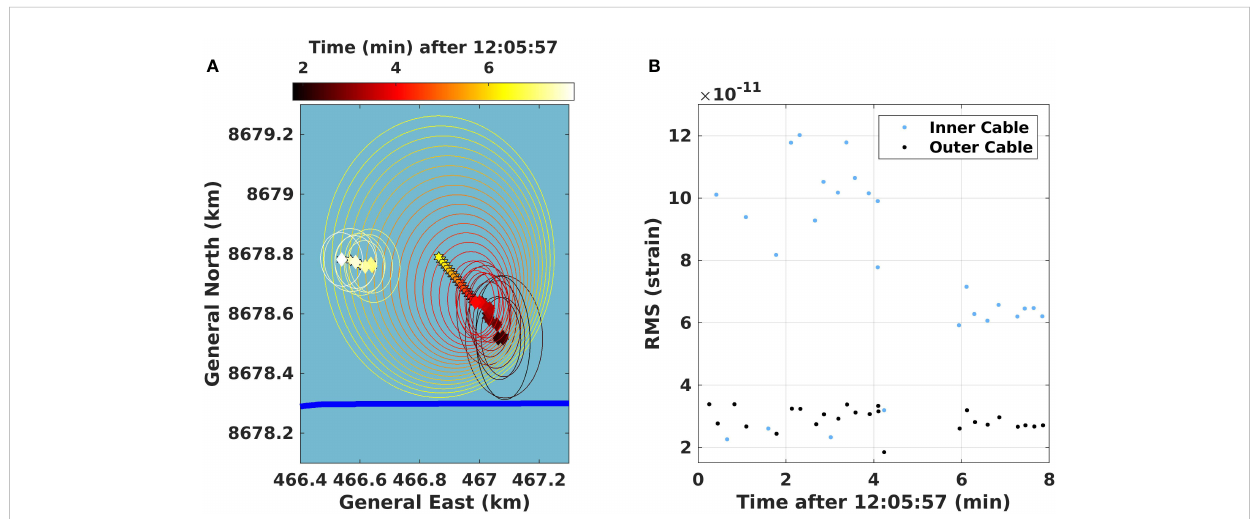
FIGURE 4 Prediction of whale location during an inter-series interval. (A) A subsection of a whale track near the inner cable (bold blue line; 12:06 – 12:14) with a 1 min 51 s inter-series interval. BF tracks are computed roughly every 10 s, and in inter-pulse intervals, we predict the position without updating (indicated by hexagram). Diamonds indicate the predictions with observed data, while the ellipses show 90% coverage regions constructed by the BF. (B) The associated RMS amplitude of the calls used in the